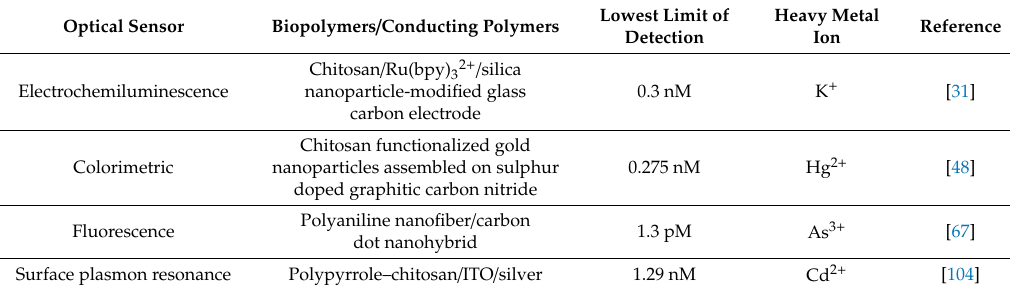
Table 3. The comparison of the limit of detection of optical